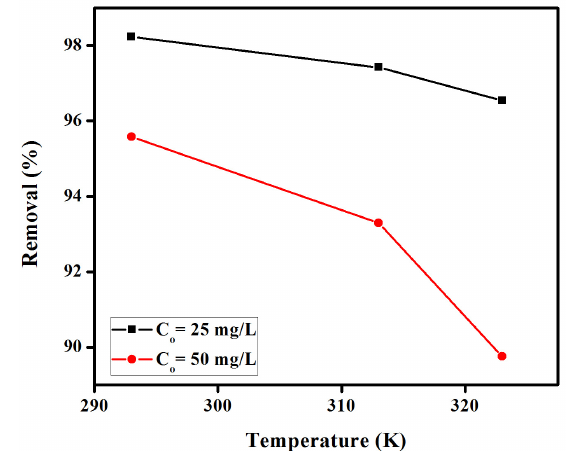
Figure 5. Effect of temperature on the removal (%) of congo red by anion exchange membrane